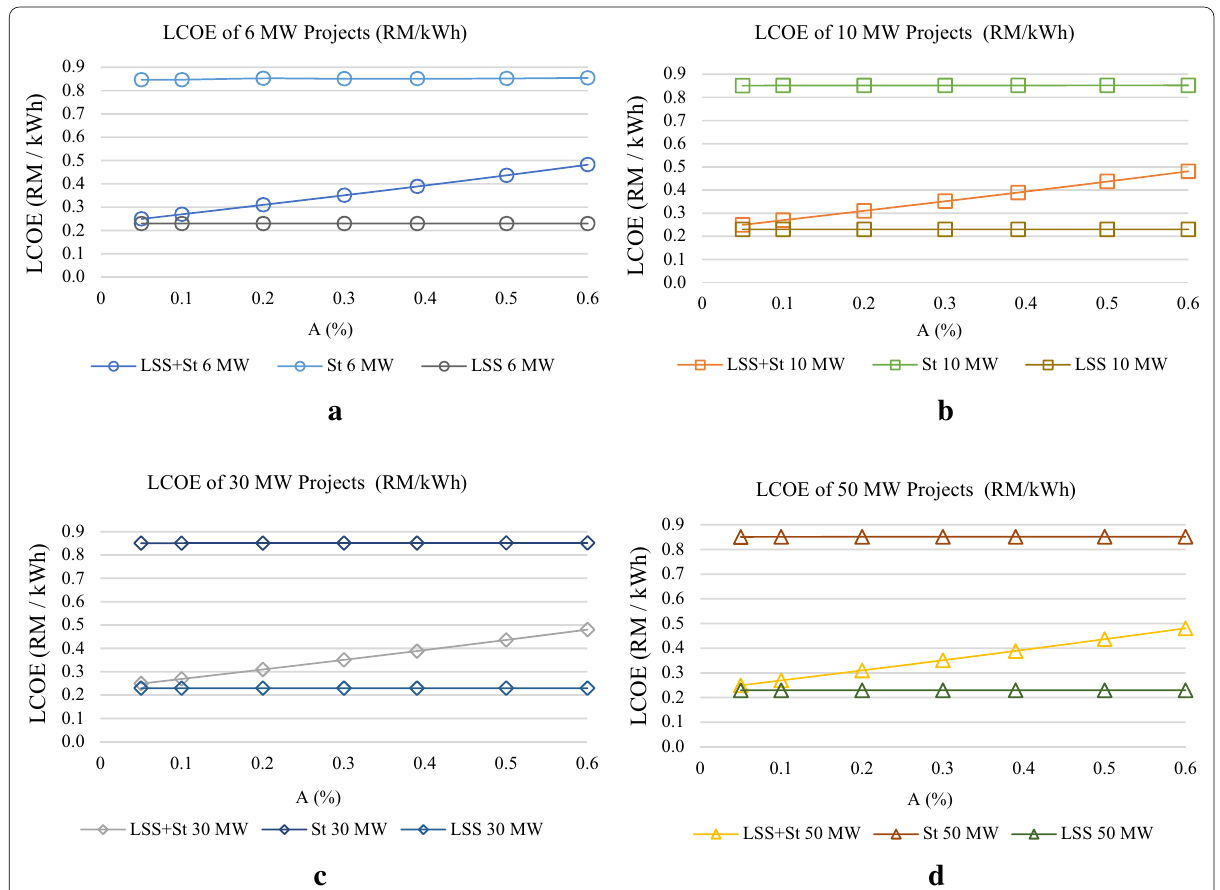
Fig. 14 Levelized cost of electricity of the different investment types for each LSS capacity in Perak. a 6-MW projects, b 10-MW projects, c 30-MW projects, d 50-MW